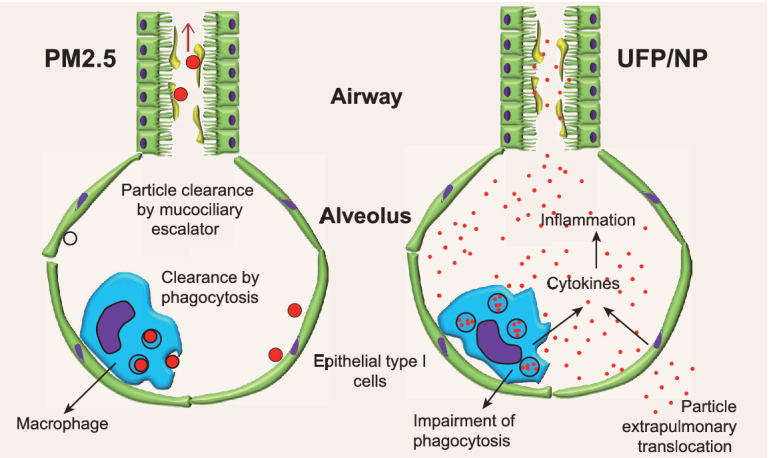
Scheme for physicological and toxicological events occurring after PM2.5 and UFP/NP exposure. PM2.5 mostly sticks to the airway, where they are cleared by mucociliary escalator. The remaining PM2.5 particles that get inside the alveoli will be phagocytosed by resident macrophages. However, for UFPs and NPs, the majority of the particles will get inside the alveoli, where the cellular uptake of nano-sized particles by macrophages is impaired, leading to delayed clearance of particles and generating oxidative stress and pro-inflammatory effects by macrophages and epithelial cells because of prolonged exposure to particles. The prolonged interaction between particles and the epithelium also lead to extrapulmonary translocation to the lung interstitium and even into the circulation. Adapted from [17].